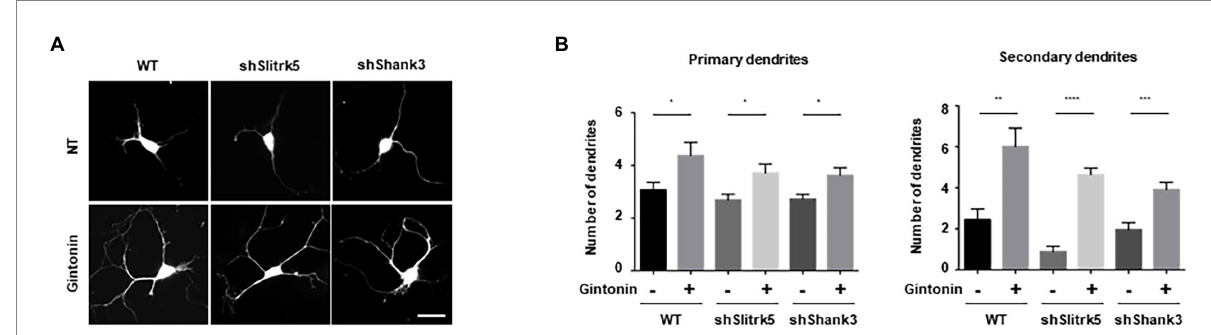
FIGURE 5 Gintonin rescued the abnormal dendritic growth in striatal neurons with Slitrk5 and Shank3 knockdown. (A) Representative images of gintonin- treated striatal neurons with wild-type (WT), Slitrk5, and Shank3 knockdown. DIV2 striatal neurons were transfected with pLVTHM scrambled, pLVTHM-shSlitrk5, and pLVTHM-shShank3, and treated with 3 μ g/ml of gintonin for 5 d. The cultures were fixed and stained with anti-MAP2 antibody. Neuronal processes were counted with fluorescent microscopy. Scale bar, 2 μ m. (B) Quantitation of the number of primary and secondary dendrites is shown. Results are presented as means ± SEM from three independent experiments determined from the analysis of 40 neurons per condition per experiment (* p < 0.05, ** p < 0.01, *** p < 0.0005, **** p < 0.0001, Student’s t